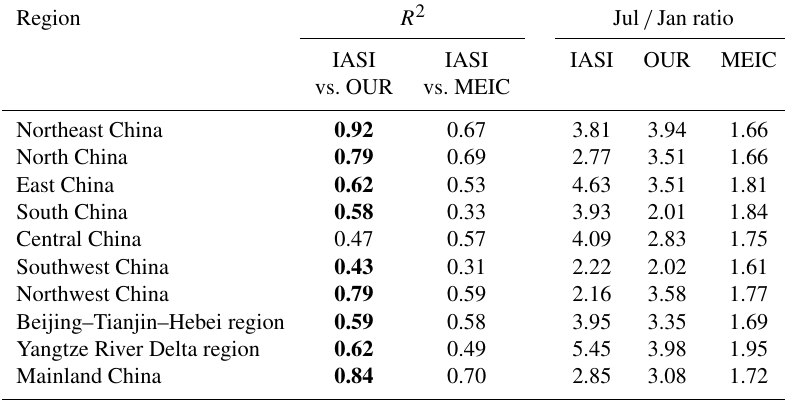
Table 4. Comparison of the monthly NH 3 emission trends corresponding to IASI satellite observations with the two inventories. Region R 2 Jul / Jan ratio IASI IASI IASI OUR MEIC vs. OUR vs. MEIC Northeast China 0.92 0.67 3.81 3.94 1.66 North China 0.79 0.69 2.77 1.66 East China 0.62 0.53 South China Central China 0.47 Southwest China 0.43 Northwest